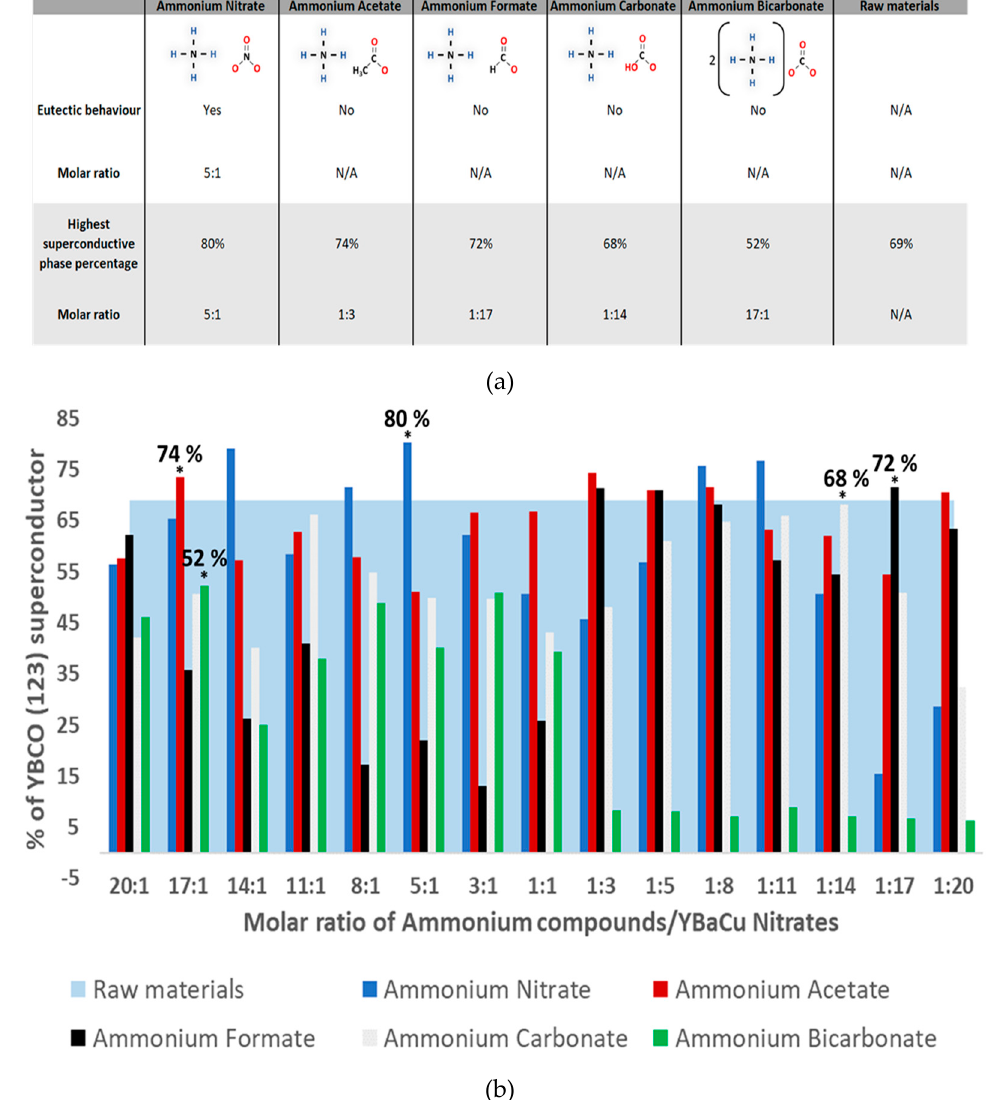
Figure 2. (a) Tabulated data summarizing the eutectic behavior of each mix of ammonium compounds and metal nitrates (white), and maximum percentage of the superconductive phase and the molar ratio at which it was obtained (gray); (b) summary of the maximum percentage of the superconductive phase obtained via different ammonium-containing compounds in different molar ratios with the metal nitrates.